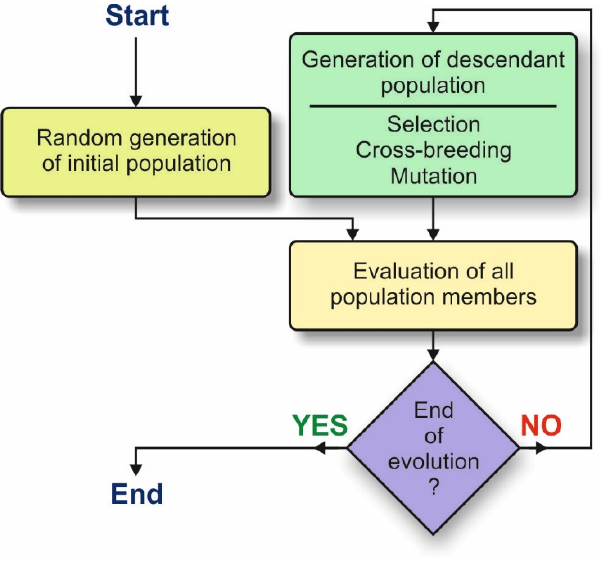
Figure 2. GA flow diagram.